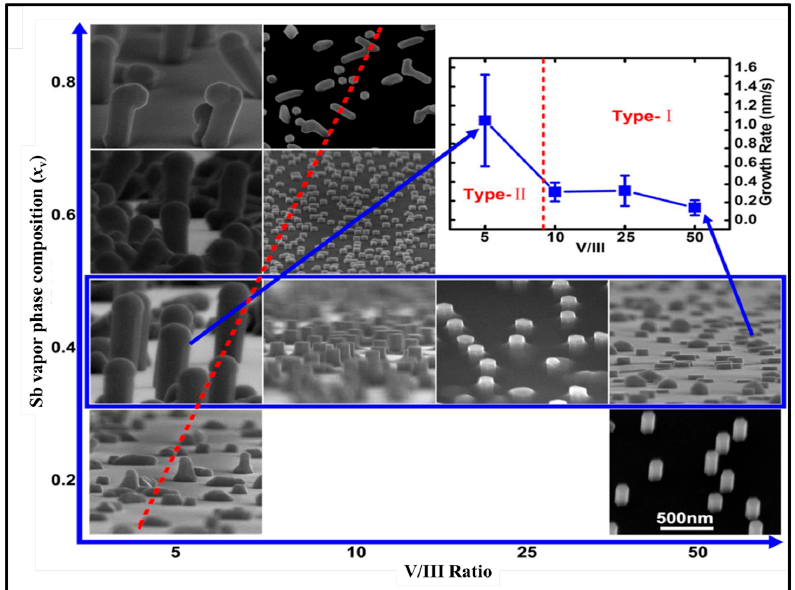
Figure 1. Images of InAsSb NWs as a function of x v and V/III ratio. The inset in the top right shows the variation of growth rate with the V/III ratio for x v = 0.4 (as highlighted by the blue rectangular frame). The solid line is used for eye guide, indicating the changing trend of growth rate. The red dashed line in the figure indicates the transition boundary between vapor–solid and vapor–liquid–solid growth modes. Reproduced with permission from [54]; Copyright 2015, American Chemical Society.